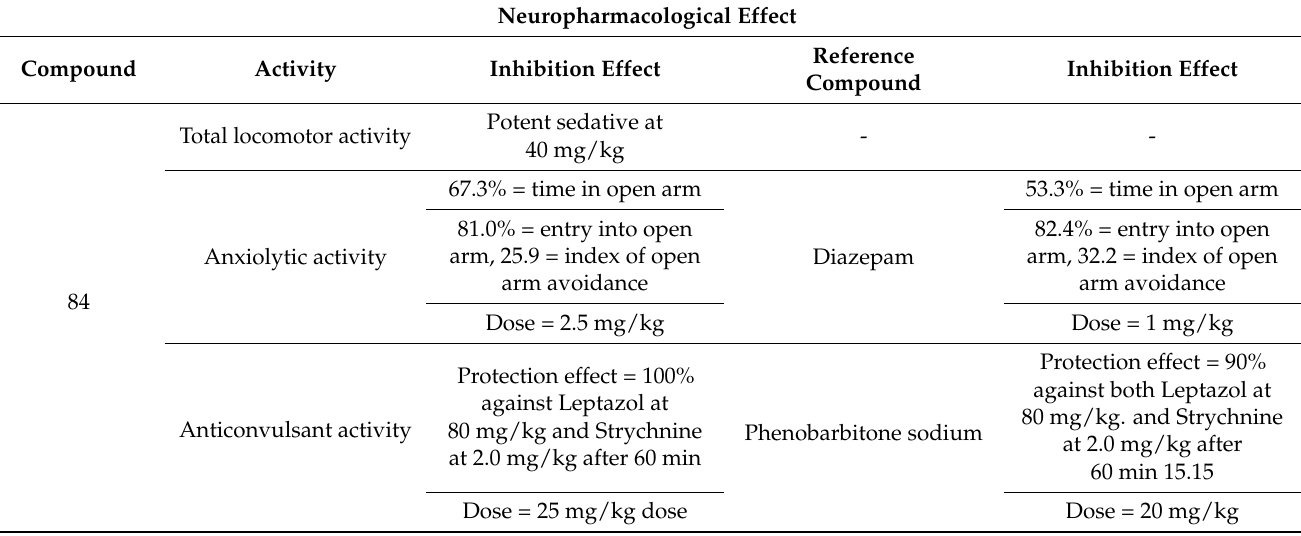
Neuropharmacological